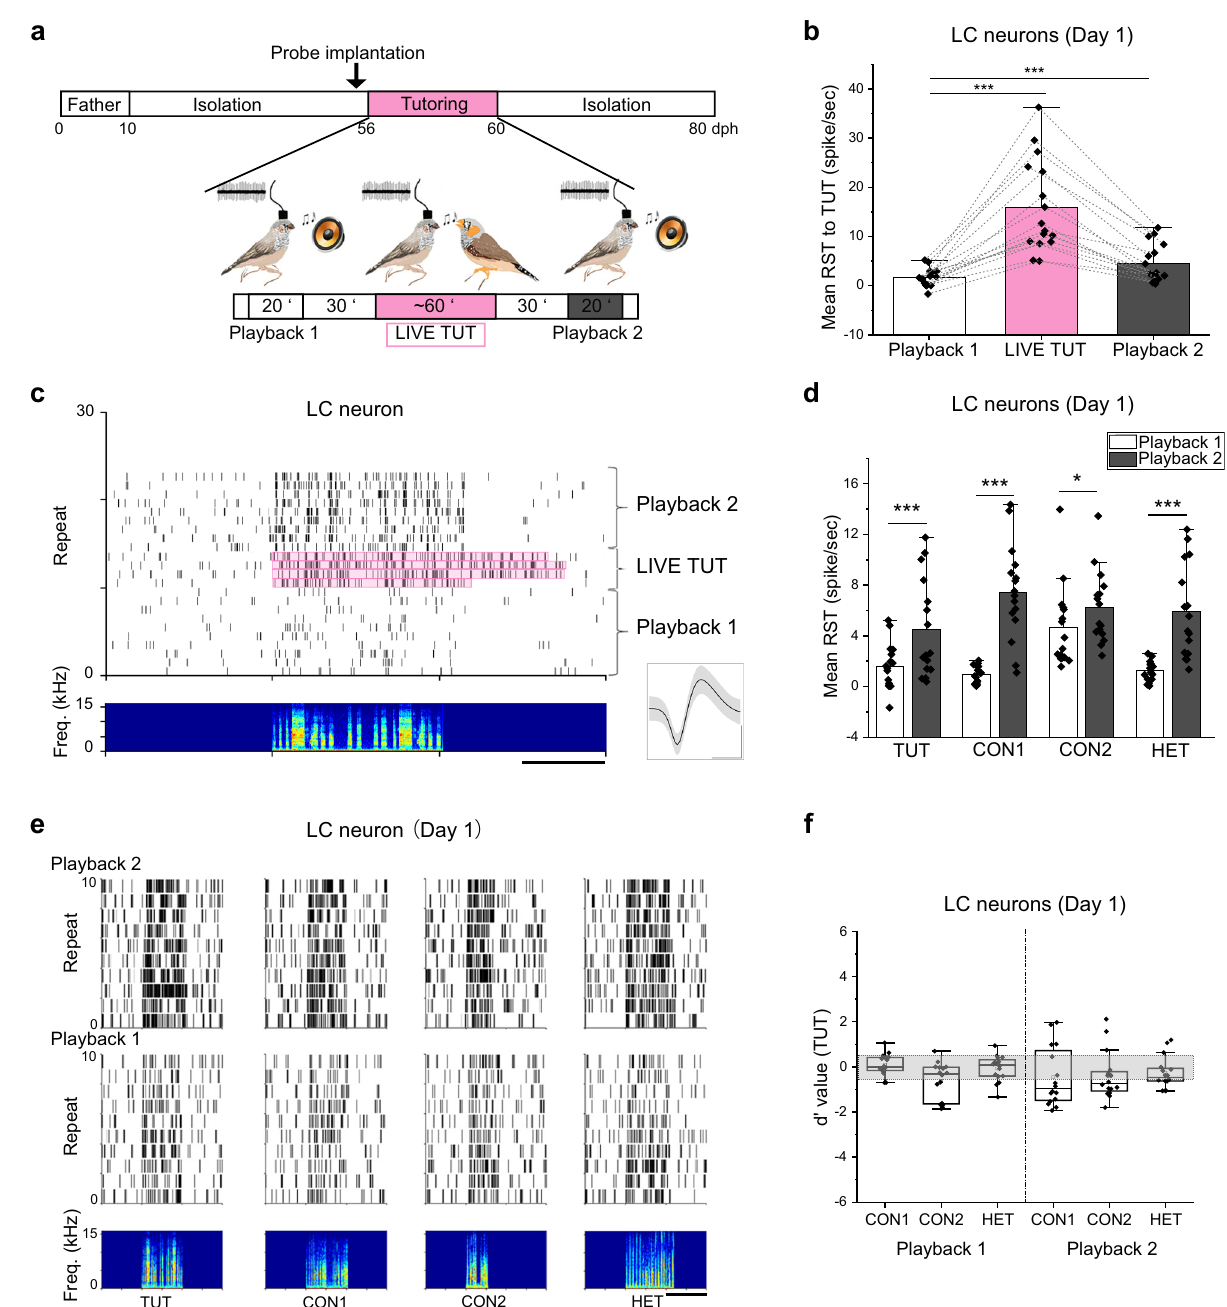
Fig. 1 | LC neurons increase auditory responsiveness to the playback of all songs after social interaction with a singing tutor. a Schematic drawings of the experimental design and timeline (dph=days, post hatch). Mean response strength (RST) of LC neurons to tutor song playback (Playback 1 and 2), tutor singing (LIVE TUT) ( b ) or playback of different songs before (Playback 1) and after (Playback 2) hearingLIVETUT( d ).RasterplotsofspikingactivitiesforasingleLCneuronbefore, during and after LIVE TUT ( c , scale bar: 1s) or to playback of different songs before (playback 1) and after (playback 2) hearing LIVE TUT ( e , scale bar: 2s) (song spec- trogramsshowninthebottom).Inset:spikewaveformofthesameLC( c ,mean±s.d., scale bars: 0.5ms horizontal, 0.5mV vertical). f Mean d-prime values for TUT over